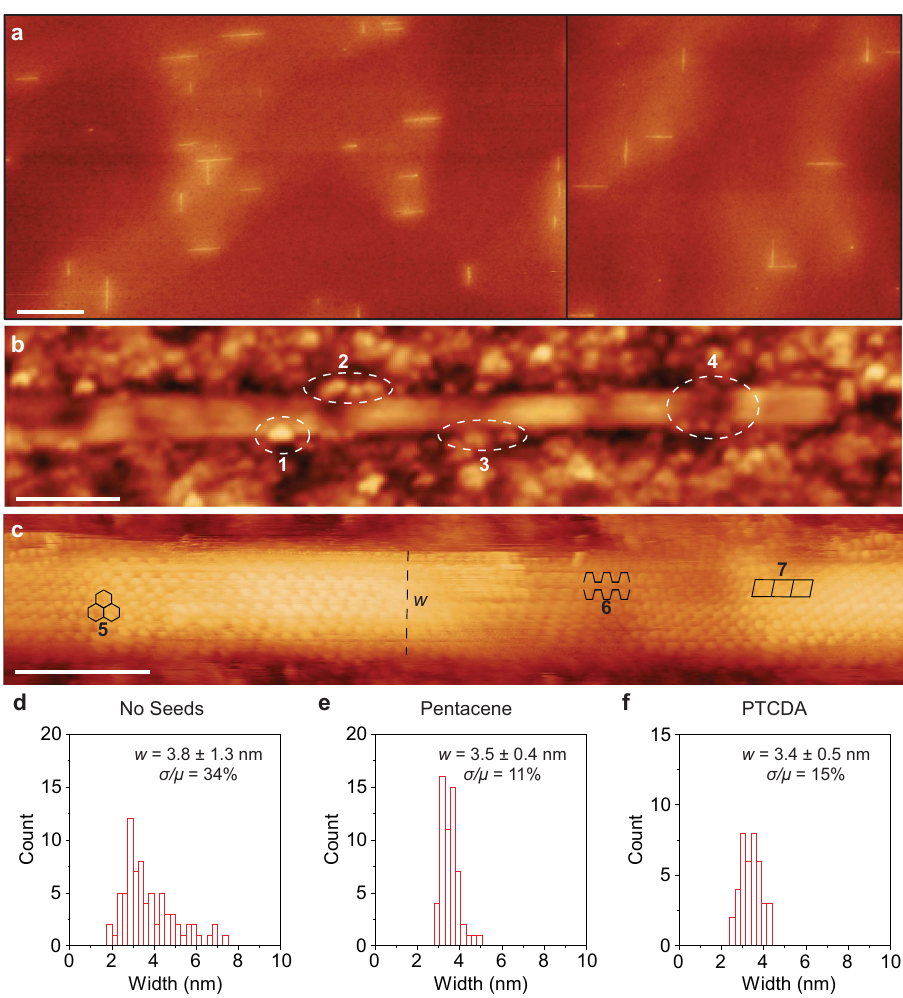
Fig. 4 Width distribution of PTCDA-derived seeds. a Large area STM images of nanoribbons initiated from PTCDA-derived seeds after 46 min of CH 4 exposure (applied bias = 2 V, tunneling current = 0.1 nA). Scale bar is 200 nm. b High magni fi cation STM image of an individual nanoribbon